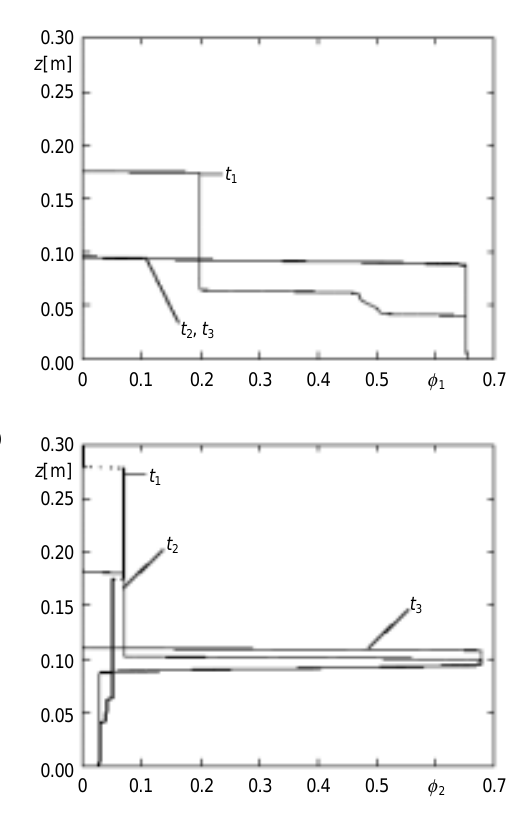
Fig. 11 Settling of a bidisperse suspension of heavy particles of two different sizes: concentration profiles (a) of the larger particles and (b) of the smaller particles (index 2) at t 1 (cid:2) 51.9 s, t 2 (cid:2) 299.8 s and t 3 (cid:2)